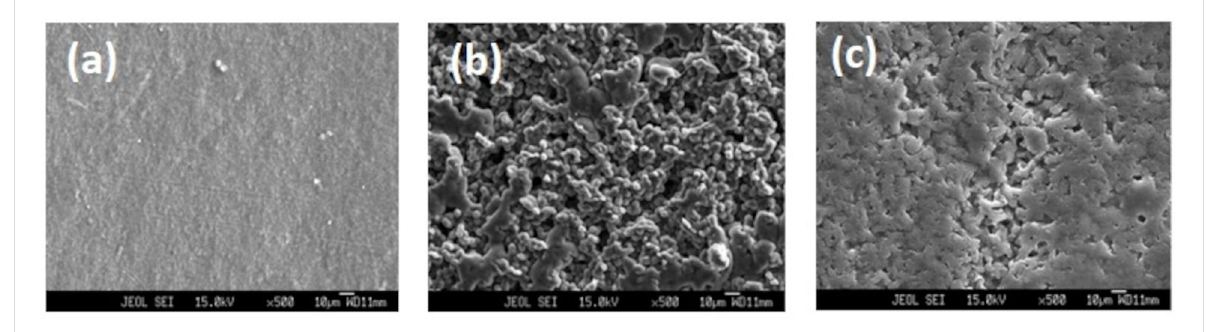
Figure 1: SEM images of (a) PVdF-HFP, (b) {(PVdF-HFP)-[BDiMIM][Cl]} (4:6), and (c) ({(PVdF-HFP)-[BDiMIM][Cl]} (4:6)) (20 wt %) + [PC-Mg(ClO 4 ) 2 (0.3 M)] (80 wt %)